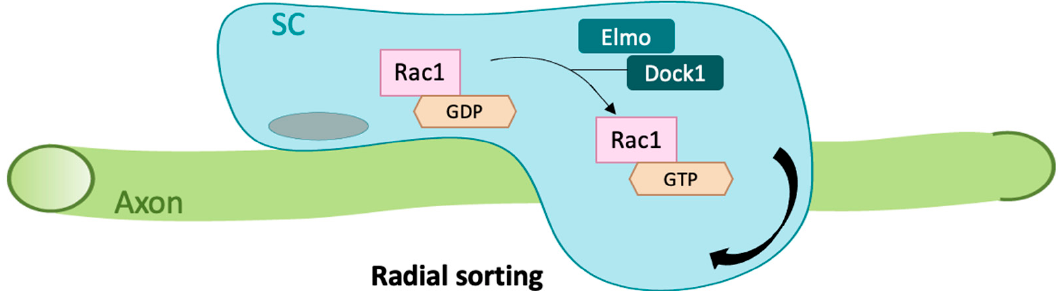
Figure 1. Role of Elmo1 / Rac1 signaling during zebrafish Schwann cell development. Elmo1 acts in association with Dock1 to enhance Rac-specific guanine nucleotide exchange factor (GEF) activity of Dock1 by mediating a GDP to GTP exchange on Rac1. Elmo1 function is linked to Rac1 activity within Schwann cells and contributes to the radial sorting process in which a Schwann cell associates with a single axonal segment via cytoskeletal rearrangements. SC, Schwann cell. At the subcellular level, it has been shown that the Elmo1-Dock1-Rac1 complex is required for ciliogenesis in zebrafish by influencing Ezrin phosphorylation and therefore orchestrating ciliary basal body migration, docking and positioning